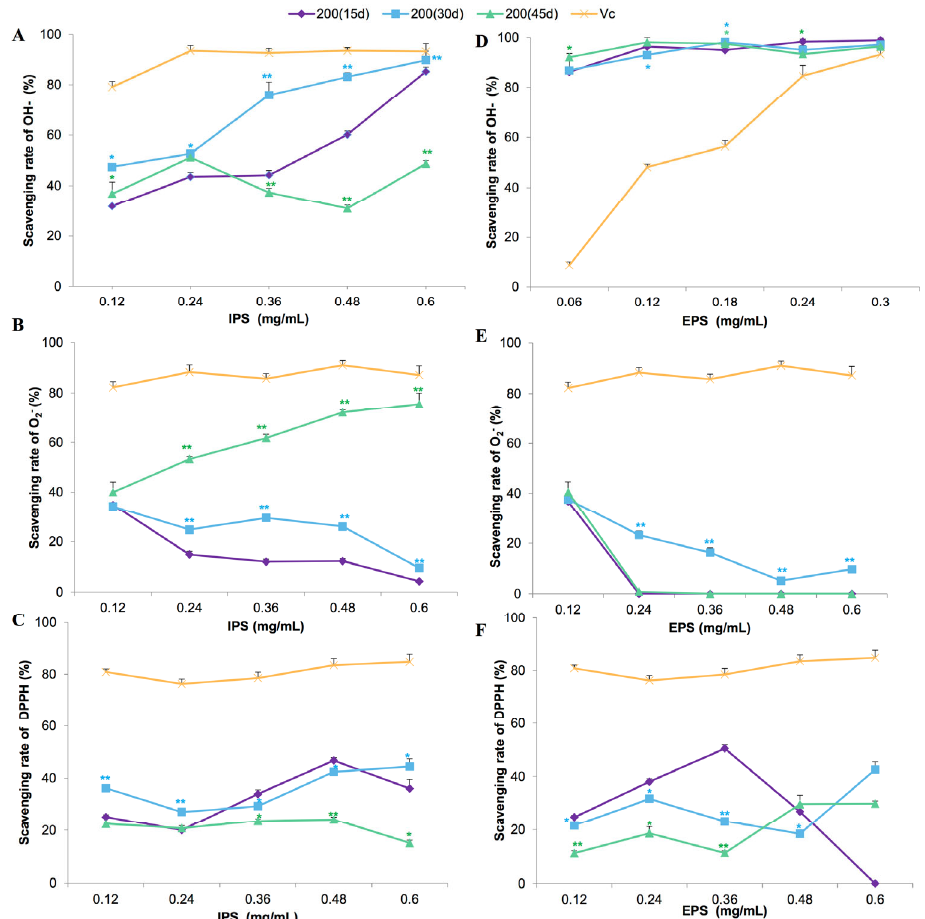
Figure 6. The in vitro scavenging effects of intracellular (IPS; A – C ) and extracellular (EPS; D – F ) polysaccharides from Lentinula edodes 808 (ACCC 52357) cultures on –OH ( A , D ), O 2 − ( B , E ), and DPPH ( C , F ) radicals. Polysaccharides were extracted from liquid static cultures with 200 mg/L Fe 2+ , added after 7 days of shaking at 150 rpm and 3 days of static culture, and incubated under static conditions at 25 °C for 15, 30, and 45 days. Data are the means of three replicates ± SD. Asterisks indicate a significant difference at p < 0.01 (**) and p < 0.05 (*), according to LSD test. Vitamin C (Vc) was assayed as a positive control. Deionized water (0) was used as a negative control.